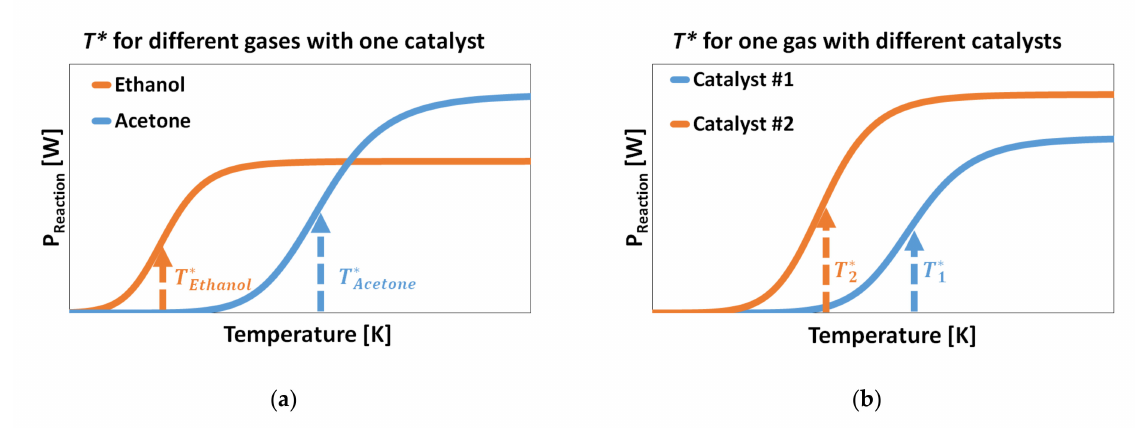
Figure 9. There are two approaches to detect the gases in binary mixtures: using ( a ) a catalytic layer for two di ff erent gases or ( b ) a specific catalytic layer for each